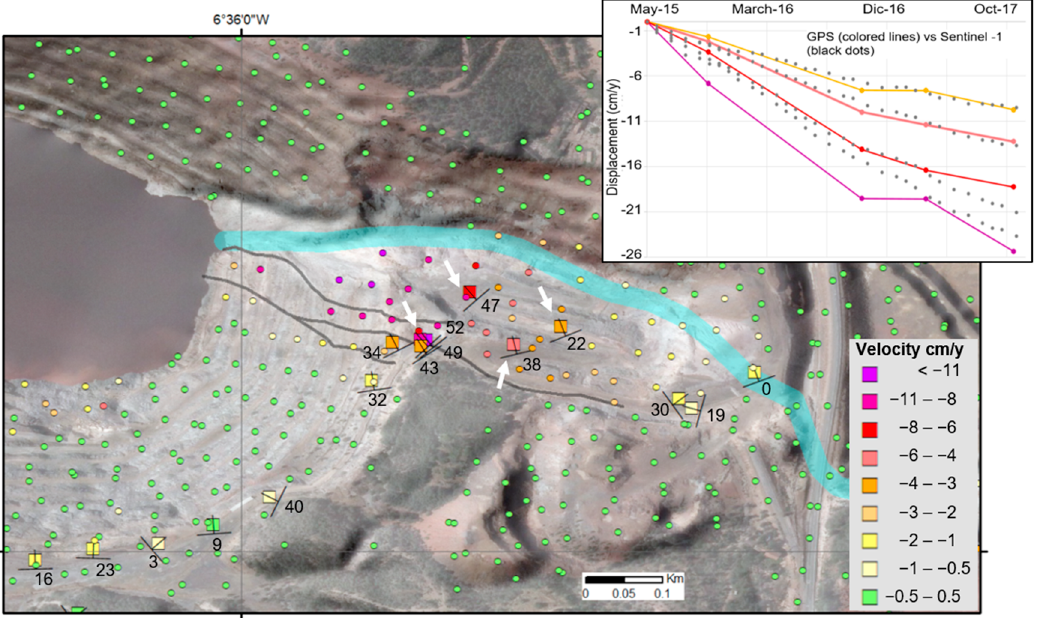
Figure 12. Zoom in Zone 4, convergent slope in the east wall of Atalaya pit. The block slide seems to be limited by the fracture zone (black lines) and the contact of the massive sulfides with the siliciclastic sediments of the Culm Group (thick blue line). The GNSS measurements are represented by colored squares. GNSS displacement vectors are marked with dip symbols (azimuth direction), and numbers (tilt degree). The circles are the calculated velocities from Sentinel-1 (Figure 8). The color scale is valid for both squares and circles. The white arrows show the GNSS—Sentinel-1 correlation points. The graph compares cumulative displacement from May 2015 to November 2017 between the Sentinel-1 (black dots) and GNSS (colored lines) displacement.